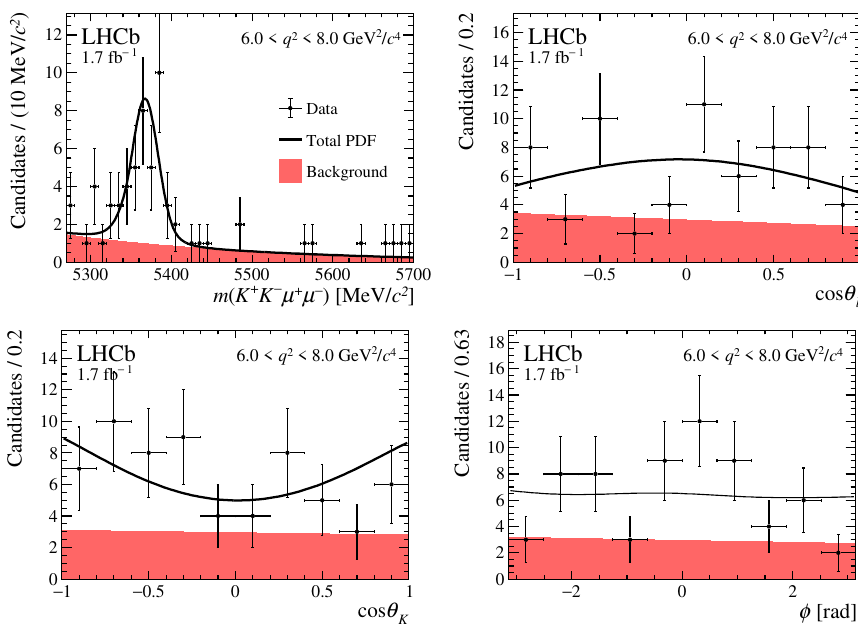
Figure 22 . Mass and angular distributions of B 0 6 . 0 < q 2 < 8 . 0 GeV 2 /c 4 for data taken in 2016. The data are overlaid with the projections of the fitted PDF.